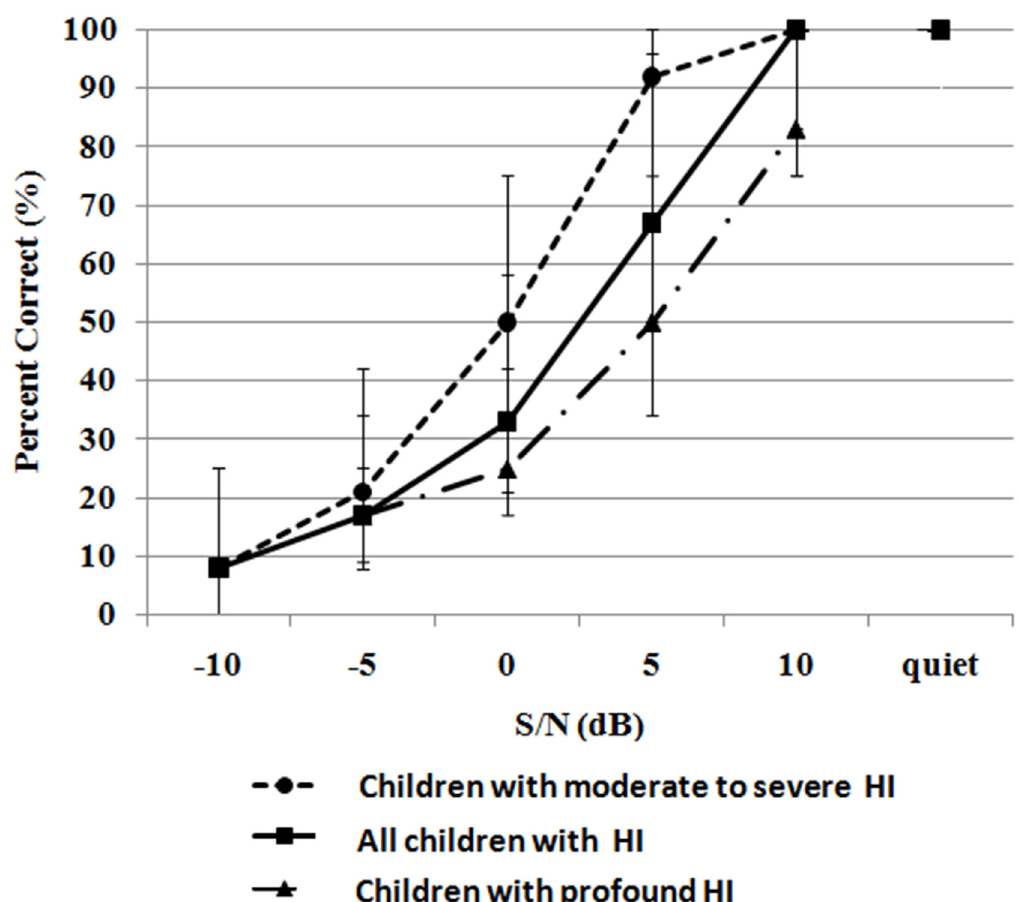
Fig 4. Median sentence identification scores in quiet and in five noisy conditions. The error bars denote interquartile range. Note for all children with HI: the median scores at -5, 0, 5 and 10 dB S/Ns were calculated from two groups of children with HI. Performance at -10 dB S/N was calculated from children with moderate to severe HI because the task was too difficult for children with profound